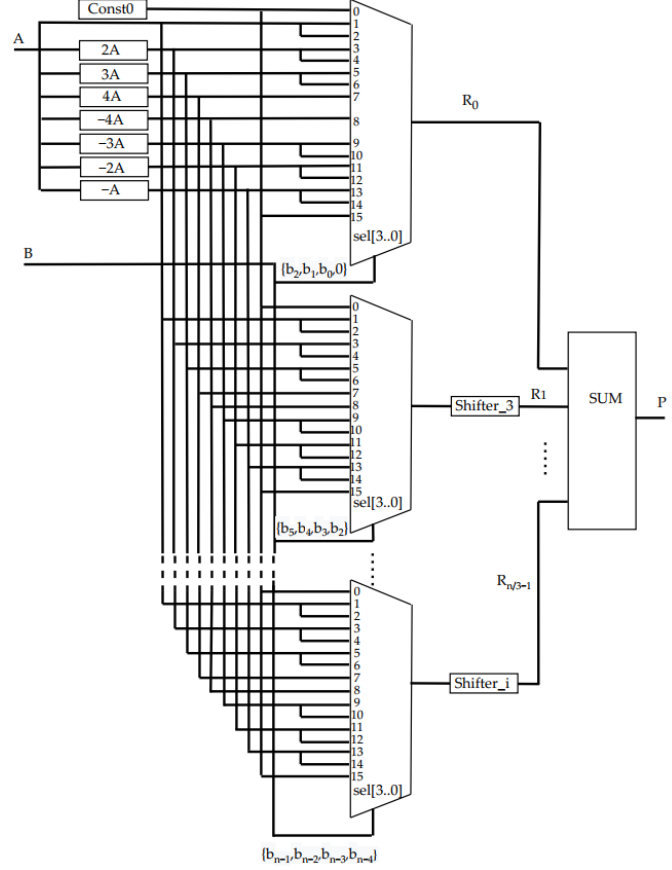
Figure 4. Architecture of the unit implementing the proposed algorithm for fast multiplication by three digits at a time.